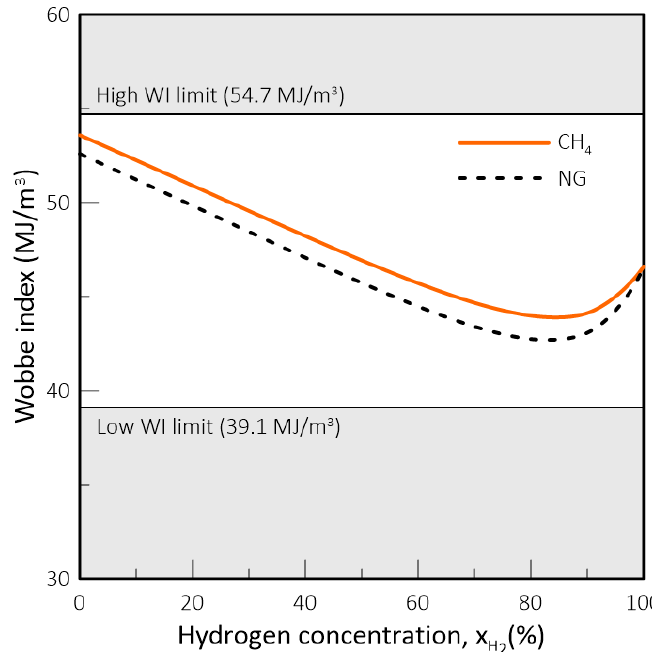
Figure 6. Wobbe index of NG and CH